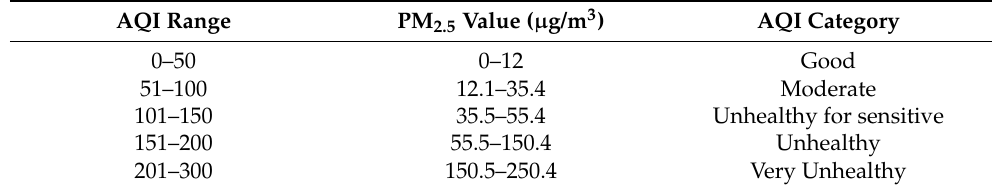
Table 1. EPA AQI Table for PM 2.5 concentration (24 hour avg.).